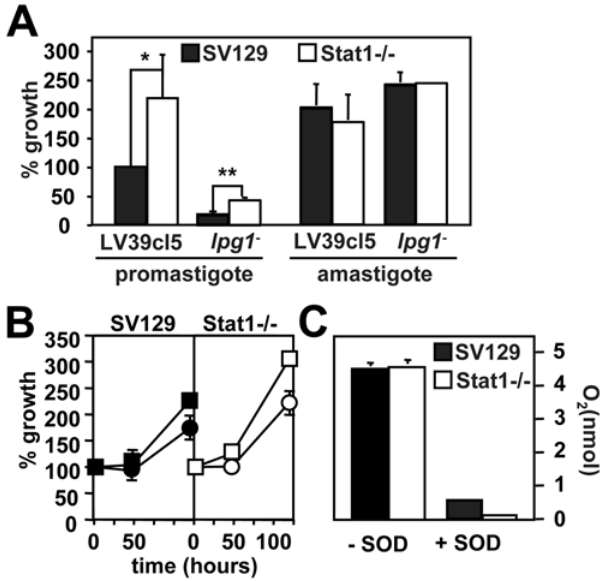
Figure 2. Stat1-deficient macrophages are more permissive for Leishmania infection. (A and B) Macrophage infection. (A) Wild-type and lpg1 2 promastigotes (left panel) or lesion-derived amastigotes (right panel) were opsonized with C3b and incubated with peritoneal macrophages derived from SV129 control and Stat1 2 / 2 mice. The number of intracellular parasites was estimated by nuclear staining and fluorescence microscopy throughout the infection period. Parasite survival at day 5 (for promastigotes) and at day 2 (for amastigotes) was normalized to the initial infection efficiencies at 2 h post-infection. Three independent experiments were performed and the bars show the standard deviations of one representative triplicate experiment. *, p=0.12; **, p=0.01. In (B), parasite survival was determined in untreated (circles) and NMMA-treated PEMs (squares). (C) Superoxide determination . Superoxide production of confluent monolayers of SV129 control and Stat1 2 / 2 peritoneal macrophages was determined by ferrycytochrome c reduction assay following incubation with zymosan in the presence ( + SOD) and the absence ( 2 SOD) of 100 ng/ ml superoxide dismutase. The optical density of the supernatants was determined spectrophotometrically using supernatants from untreated cells as